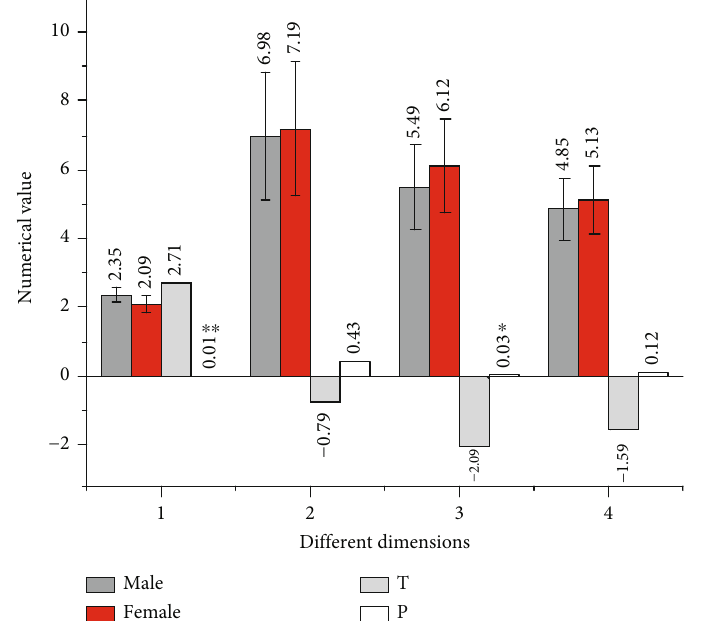
Figure 4: Di ff erence comparison results of personality traits (1: psychoticism; 2: Introversion-extroversion; 3: neuroticism; 4: concealment; ∗∗ P < 0 : 01 ; ∗ P < 0 : 05